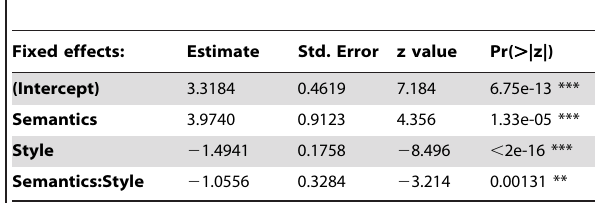
Table 4. Results of the linear mixed effects logistic regression on intelligibility data for meaningful